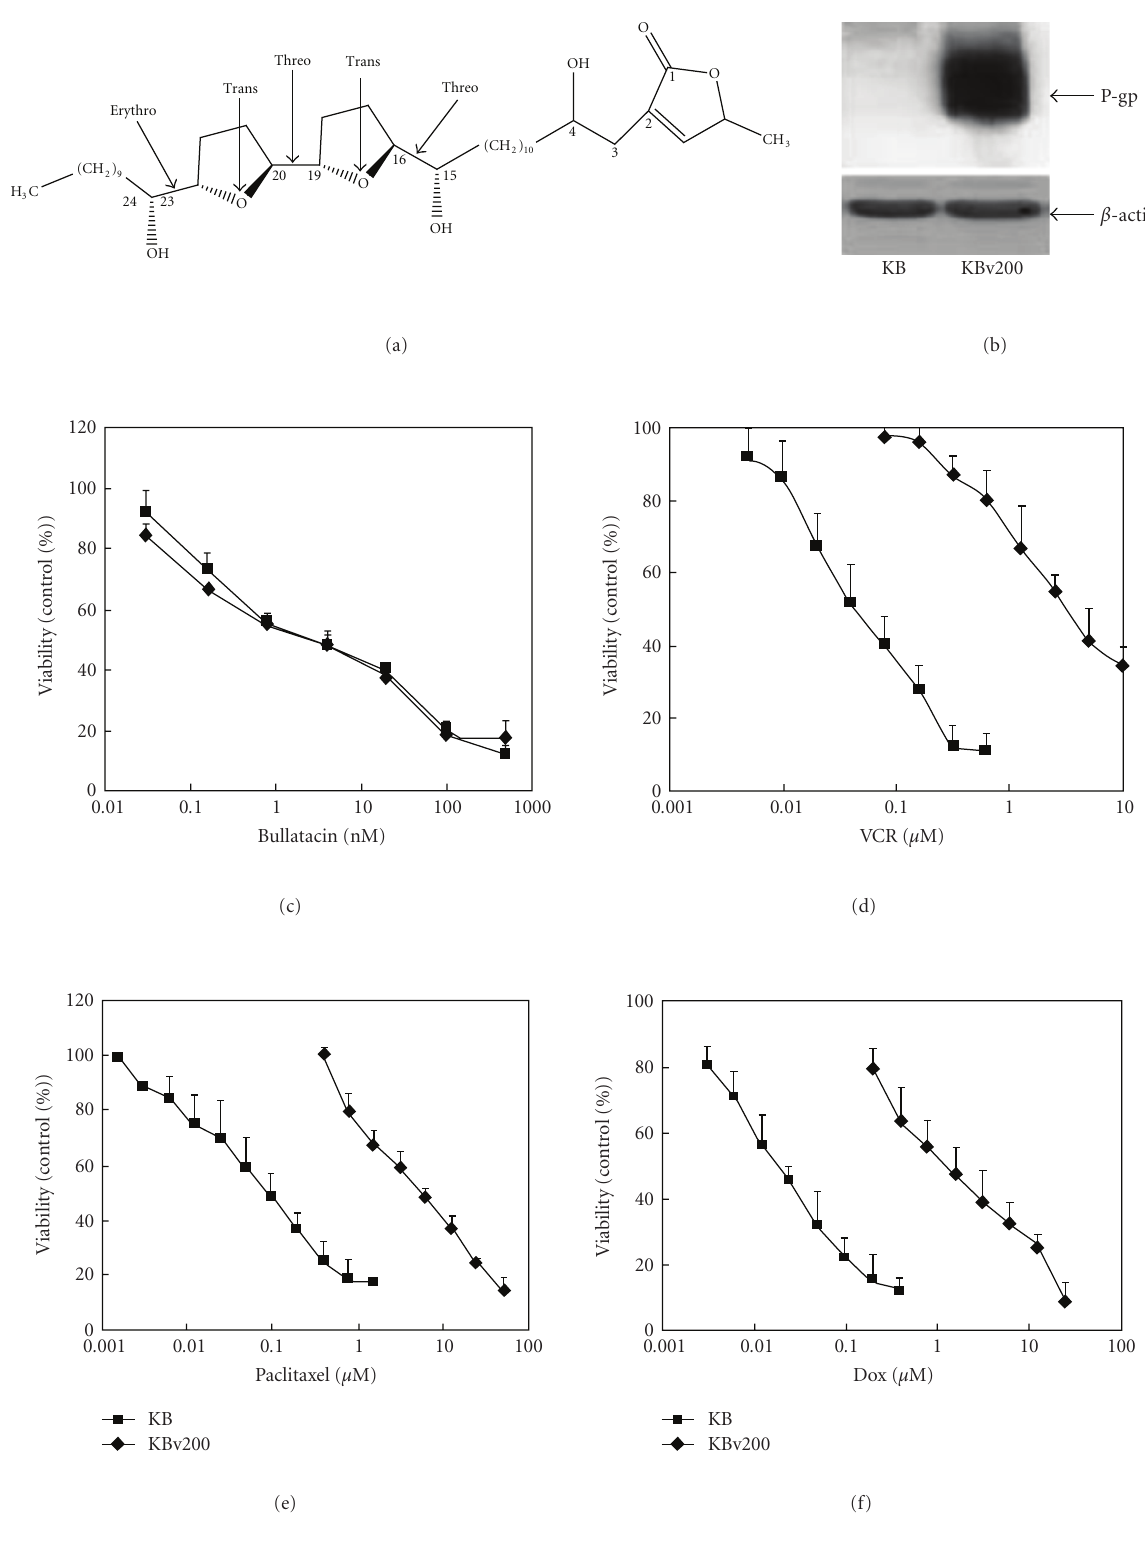
Figure 1: The structure of bullatacin (a), the overexpression of ABCB1 in KBv200 cells (b), equal amount of protein from various cells was loaded for Western blot as description in Section 2; the cytotoxicity of bullatacin (c), VCR (d), paclitaxel (e) and Dox (f) in KBv200 and KB cells. Cell survival was determined by MTT assay as described in Section 2. Data represent means and standard errors of at least a triplicate